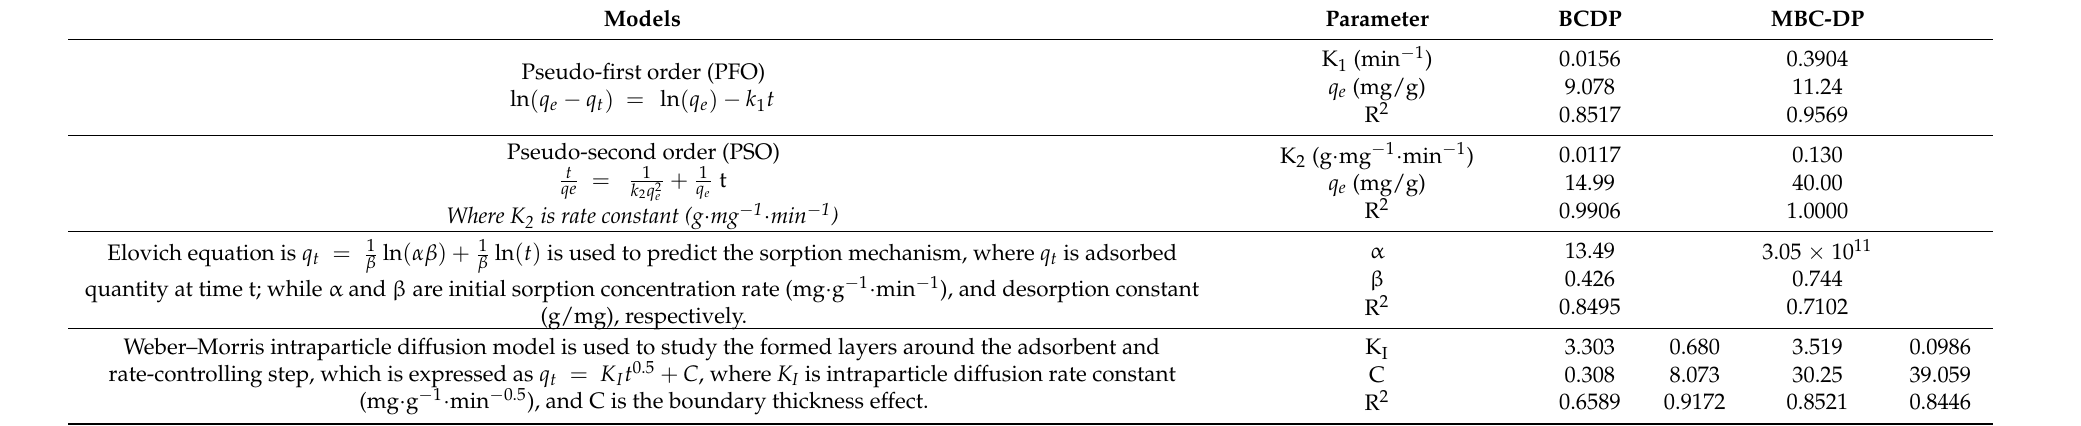
Table 7. The kinetics study results corresponding to Figure